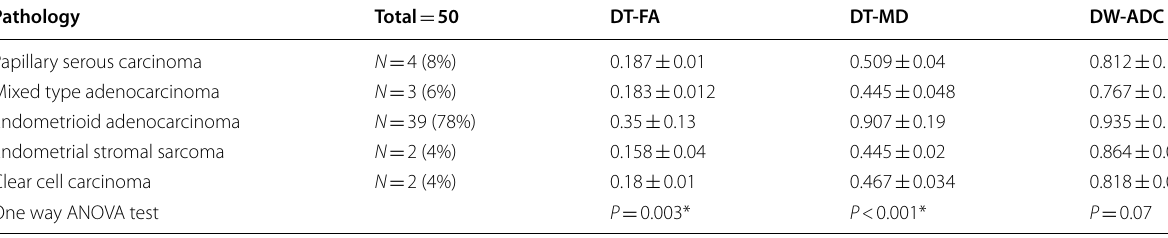
Parameters described as mean